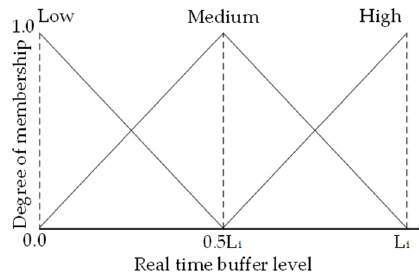
Figure 2. Membership functions of a buffer level.